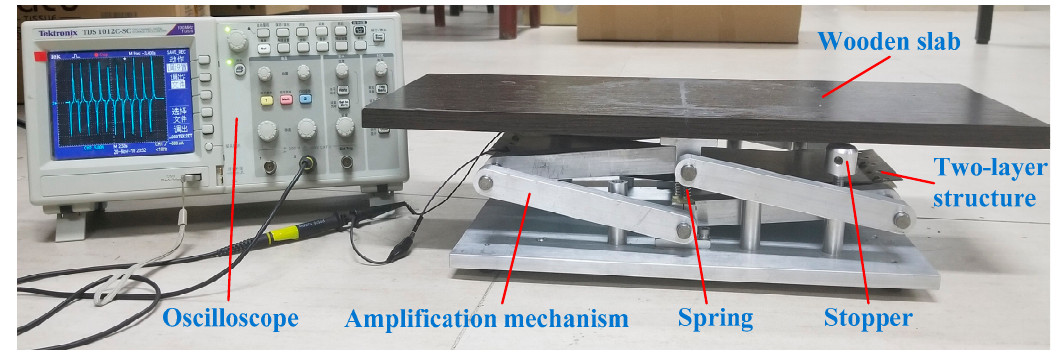
Figure 5. Prototype of the energy harvesting floor structure.